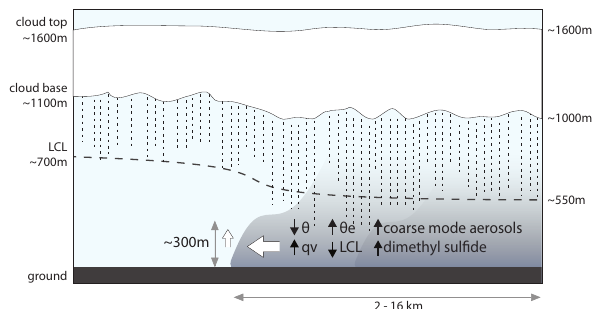
Fig. 16. Schematic showing the main properties of the cold pools identified in this